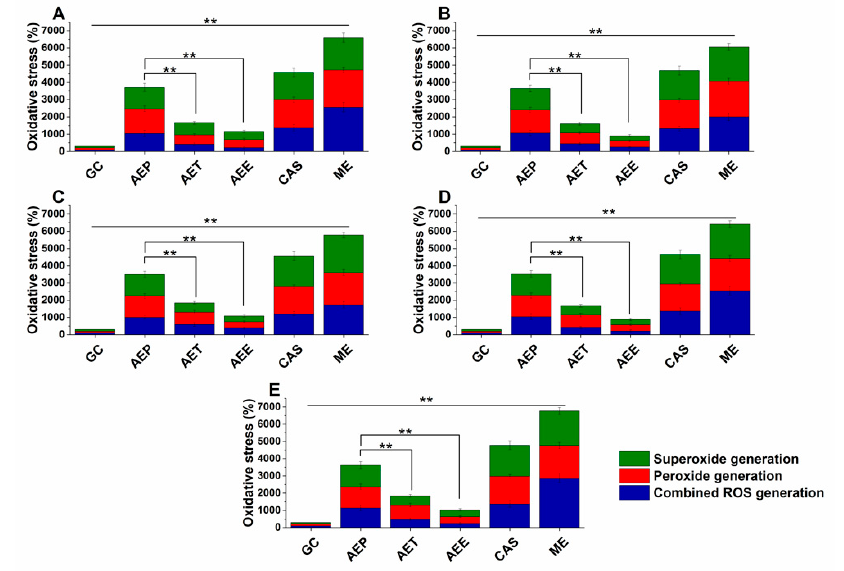
Figure 8. Percentage oxidative stress generation by AEP, AET, AEE, and CAS on S. pombe ( A ), C. albicans ( B ), C. tropicalis ( C ), C. dubliniensis ( D ) and C. krusei ( E ) at their respective MEC 10 concentrations and after one-hour treatment. All results were compared to those for menadione (ME) and growth control (GC). The three formulations were evaluated separately as well. Six independent experiments, each with three technical replicates (** P < 0.01, mean ± SD).